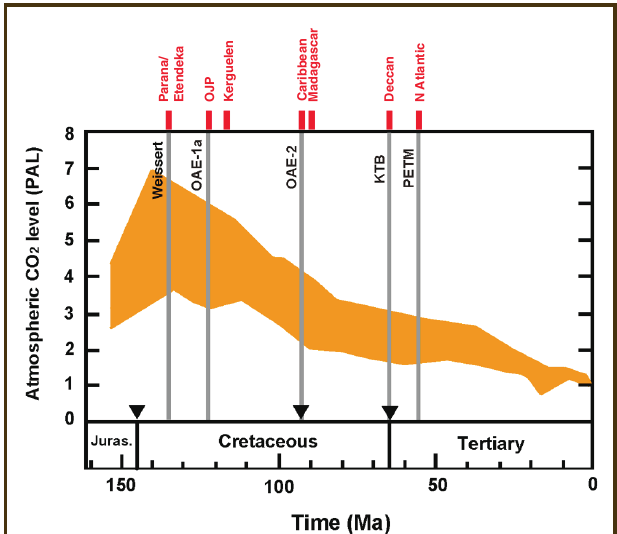
Figure 9. Estimated atmospheric CO 2 concentrations during the last 150 myr (Berner and Kothavala, 2001; Tajika, 1998). Shaded areas indicate global oceanic anoxic events (OAE-1a and OAE-2), Creta- ceous-Tertiary boundary (KTB), and Paleocene-Eocene Thermal Maximum (PETM). Mass extinctions events (Sepkoski, 1996) are shown as black inverted triangles.